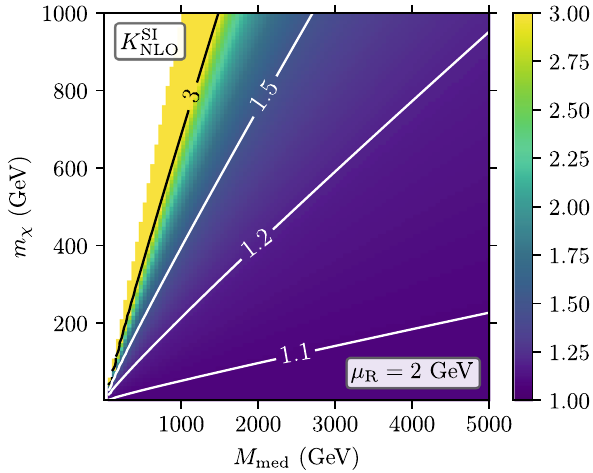
Fig. 7 K factor for σ SI p for different values of M med and m χ with a fixed value of μ R = 2